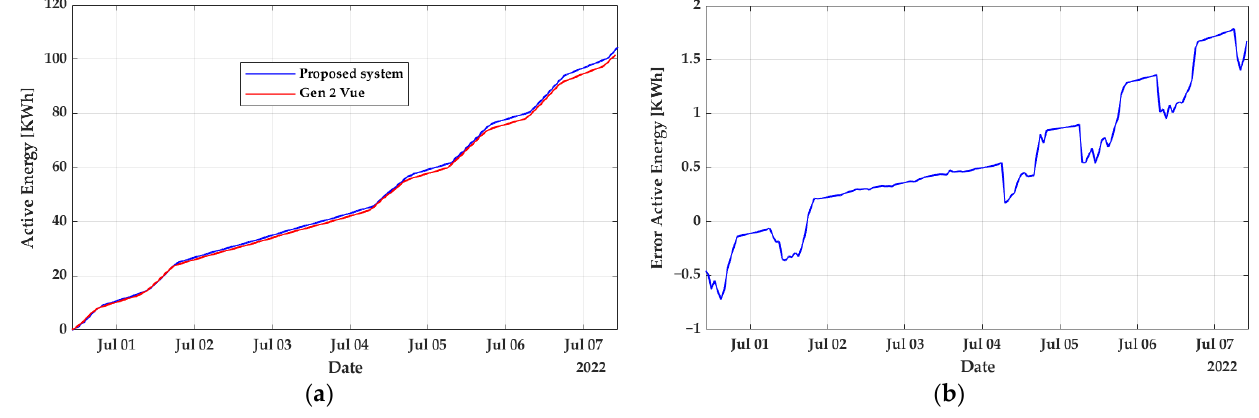
Figure 19. Active energy in line 2: ( a ) comparison between the proposed system and the commercial monitor; ( b ) measurement errors of the proposed system with respect to the commercial monitor.